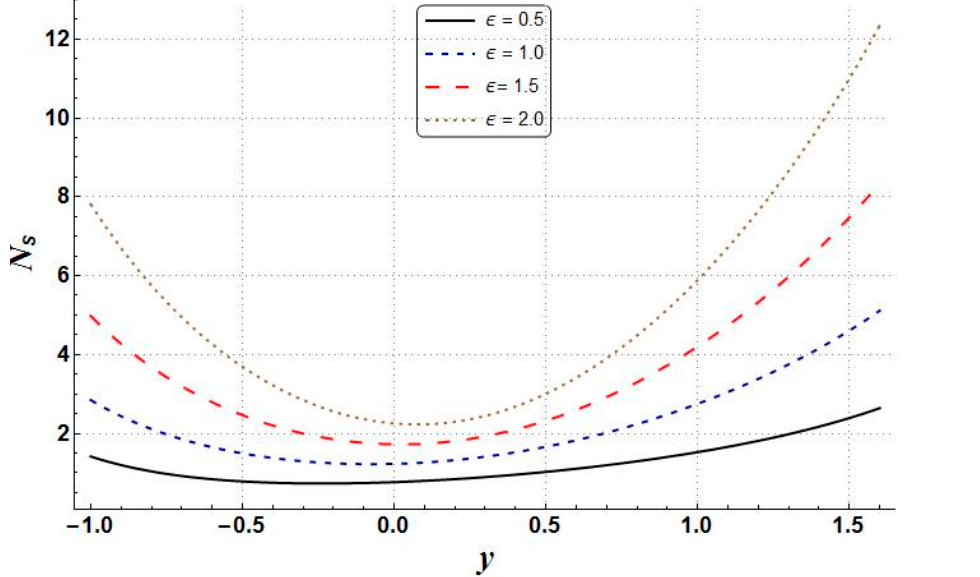
N through changing values of